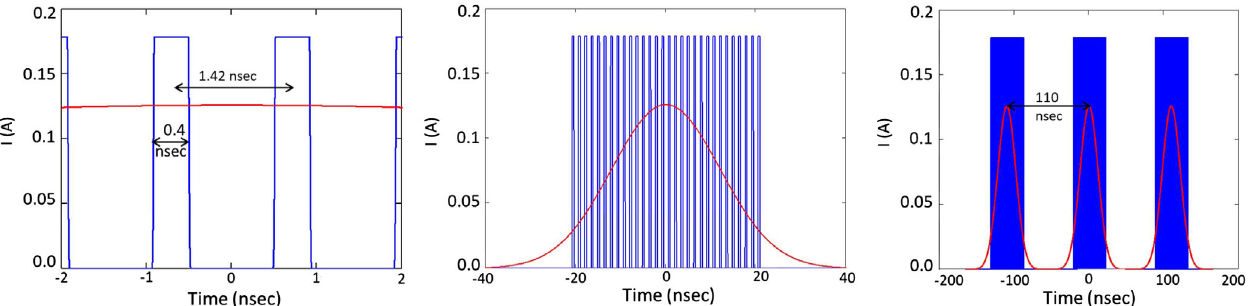
FIG. 4. LEReC and RHIC beam time structure in the cooling sections. The left shows two electron bunches spaced by 1.42 ns (corresponding to the 704 MHz LEReC laser maximum repetition frequency). The center shows one LEReC macrobunch consisting of 30 electron bunches (blue) placed over a single ion bunch (red). The right shows a train of three electron macrobunches spaced by 110 ns (corresponding to the 9.1 MHz RHIC repetition frequency) overlapped with the three ion